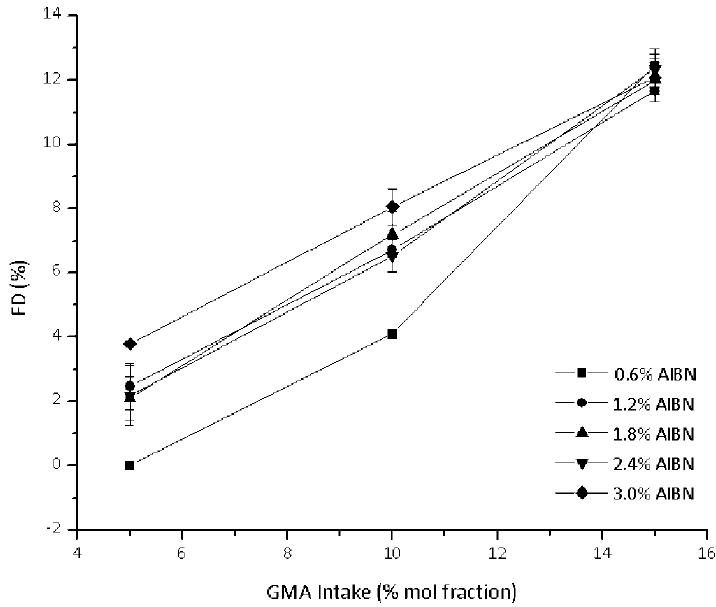
Figure 2. Effect of GMA intake on the FD values of PCL- g -GMA.